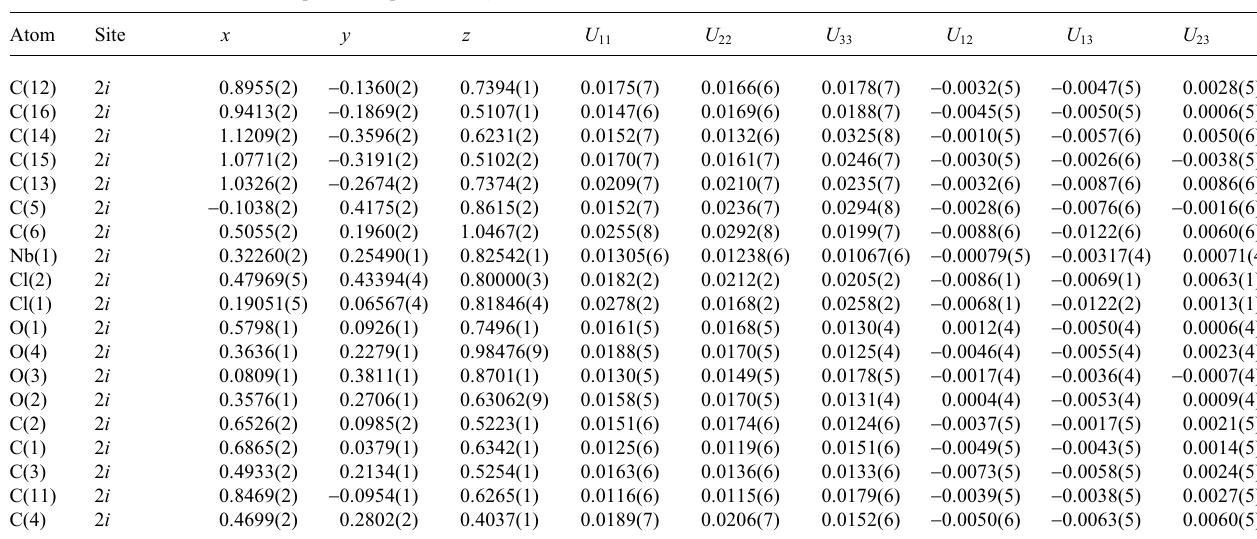
Table 3. Atomic coordinates and displacement parameters (in Å 2 ) .